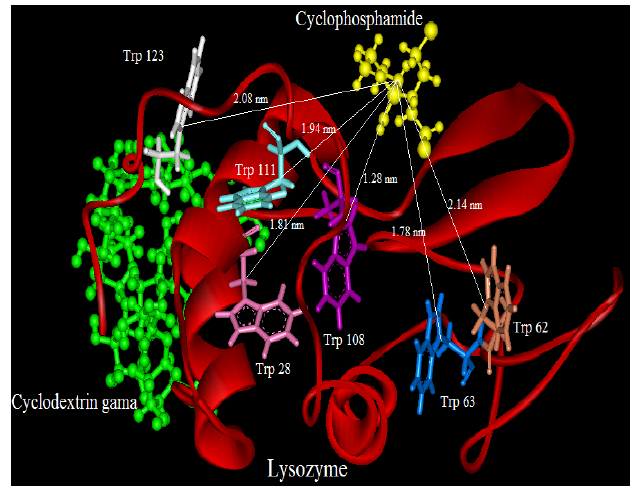
Figure 13. Distance between CYC and Trp residues in ternary system and in the presence of CD( γ ); below: show the number and type of amino acids involved in the hydrogen binding between LYZ and CYC in presence o of CD( γ